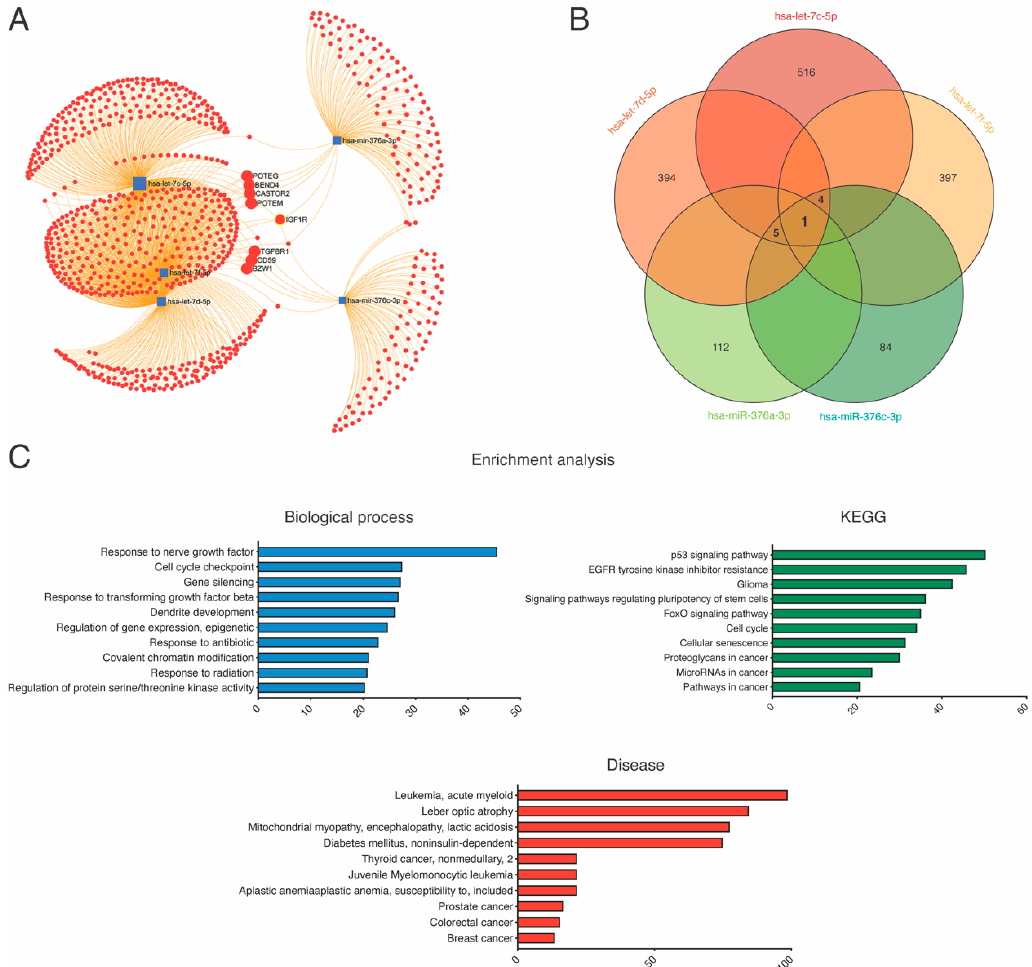
Figure 6. KEGG and GO analysis of differentially expressed miRNAs. ( A ) miRNA-gene network for let-7c-5p, let-7d-5p, let-7f-5p, miR-376a-3p and miR-376c-3p. ( B ) Venn diagram showing overlap